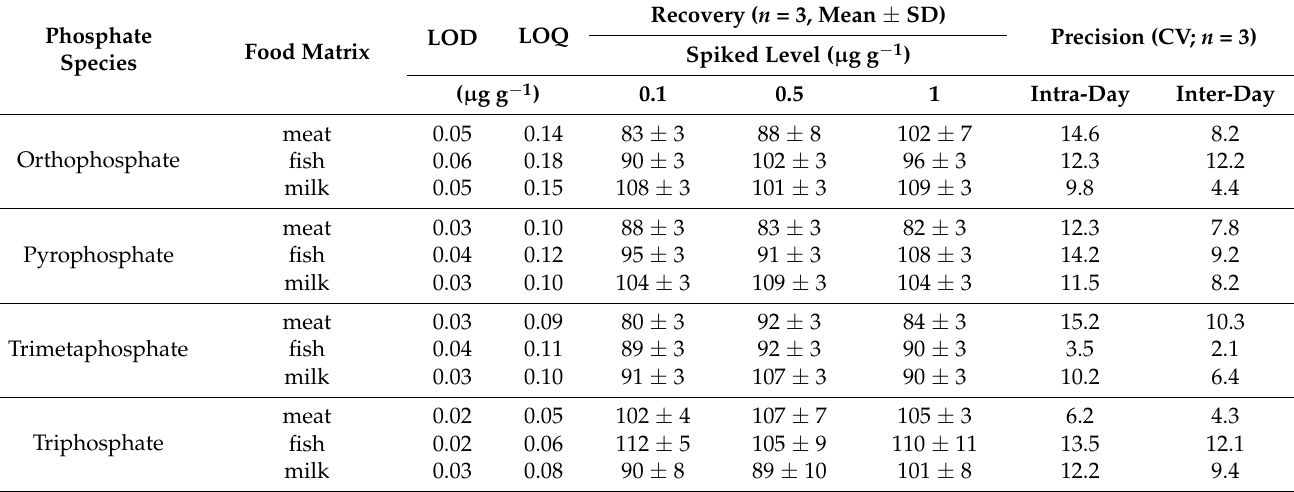
Table 2. Analytical performance and validation parameters of the proposed HPIEC–HRMS Q-Exactive methods for three food